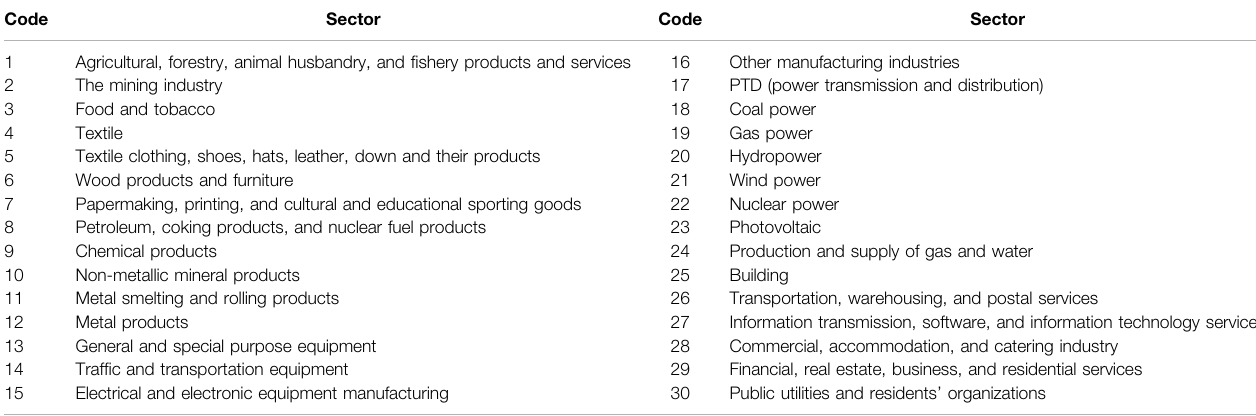
TABLE 1 | The settings of 30 sectors in SAM.